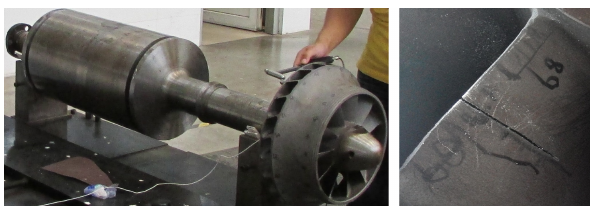
Figure 11. The impeller-shaft assembly employed in experiment and the fabricated crack.